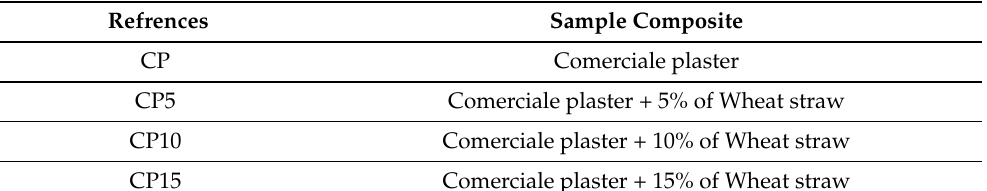
Table 1. The code and composite samples.